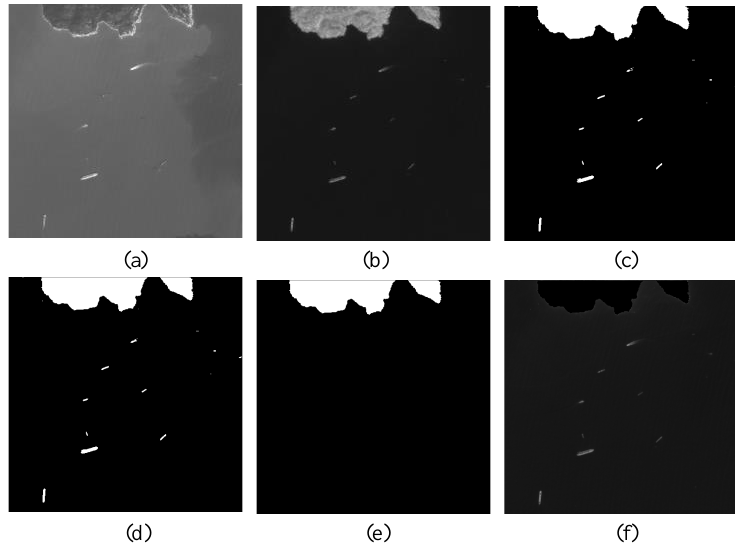
Figure 4. Sea-land segmentation with multispectral images: ( a ) green image, ( b ) NIR image, ( c ) binarizing with threshold η after calculating the NDWI, ( d ) refined by the morphology closing operation, ( e ) removing small connected regions at sea, and ( f ) removing the land area and leaving the sea area in the NIR image.